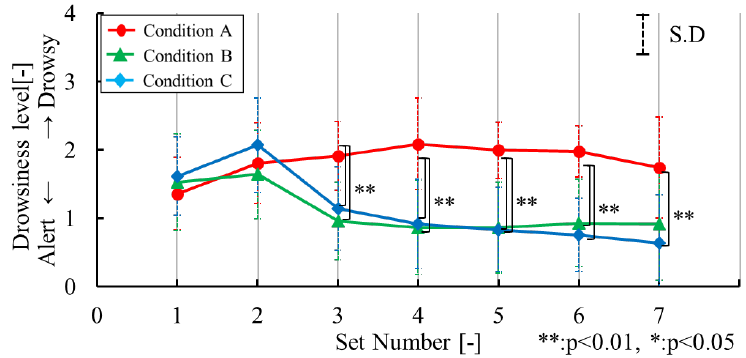
Figure 7. Result of MATH score. Figure 8. Result of response time. 4.1.4. Consideration of Thermal Stimulation for High Arousal Levels In the previous studies of Yoshida et al. [12] and Mohri et al. [13], to maintain a high arousal level, the effects of several stimulation methods, such as the use of a fragrance, alarm, and shoulder oscillation, were confirmed. As a result, the sleeping rebound occurred 10 min after the stimulation in those studies. As in our results, high arousal states were maintained for over 10 min after the removal of thermal stimulation. Though further investigation of these comparisons of the time to rebound is necessary, our results showed that thermal stimulation is effective in improving the arousal levels of occupants. Especially, our method is useful in spaces where air conditioning systems